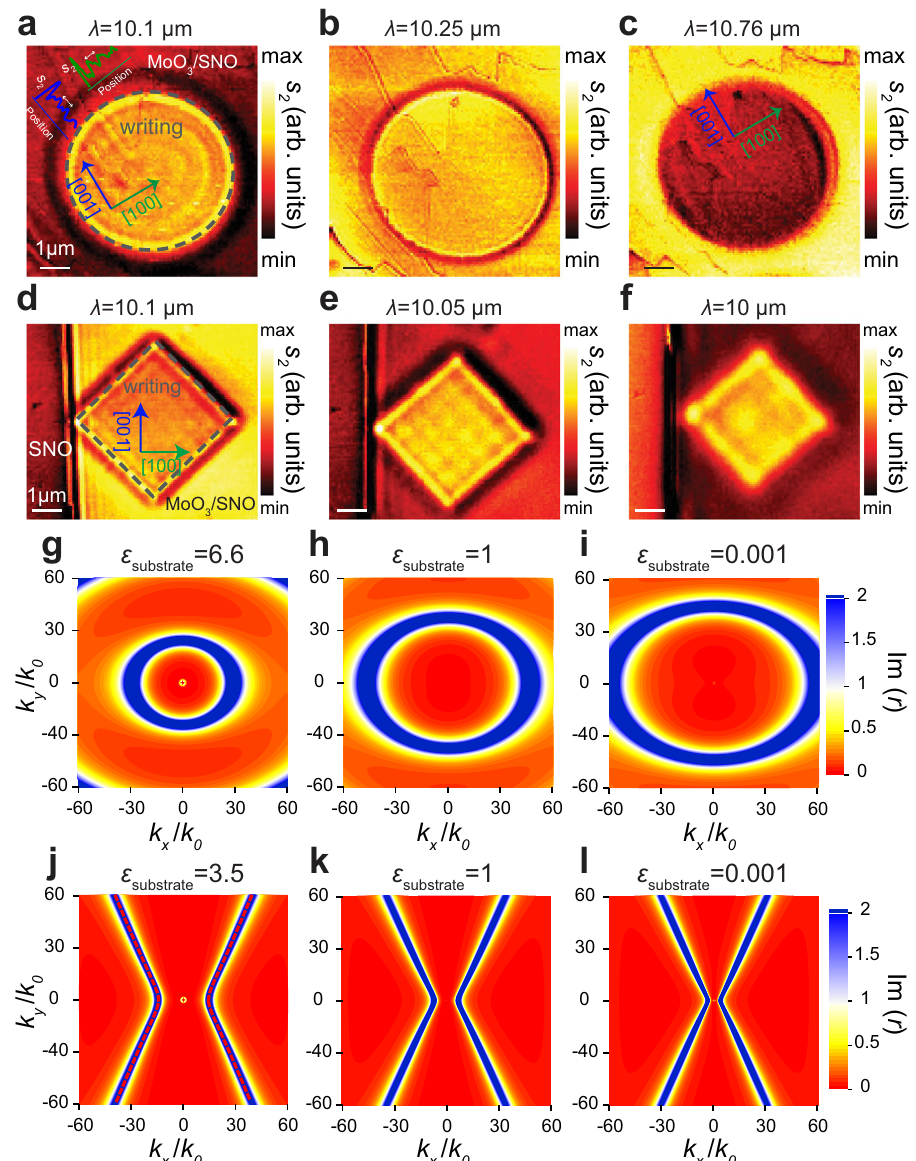
Fig.5|Tunablepolaritonicswith α -MoO 3 /SNOarchitectures. IRs-SNOMsecond transferred on the top at part ( a – c ). Gray dashed lines in panels a and d show the charge written region on SNO. g – i Simulated dispersion of polaritons for 100nm harmonic near fi eld experimental amplitude s 2 images of pristine α -MoO 3 /SNO at a λ =10.1 µ m, b λ =10.25 µ m, and c λ =10.76 µ m. The lithography pattern (a circle thick α -MoO 3 on top of the correlated oxide metasurface with different permit- tivity, at the frequency of 990.09cm − 1 . j – l Dispersion of hyperbolic polaritons for with 5 µ m diameter) was made by applying 10V potential at the c-AFM tip and a fl ake of 120nm α -MoO – c ). IR s-SNOM second 100nm thick α -MoO 3 on top of correlated oxide metasurfaces with different per- 3 is transferred on the top at parts ( a harmonic near- fi eld amplitude s 2 images of pristine α -MoO 3 /SNO at d λ =10.1 µ m, mittivity, at the frequency of 900.9cm − 1 . The graphs in the insets in panel e λ =10.05 µ m, f λ = 10 µ m, the lithography pattern (a square with 4 µ m side) was a represent the line pro fi les along the [100] and [100] directions and illustrated in made by applying 10V potential at the c-AFM tip and a fl ake of 120nm α -MoO 3 is detail in Supplementary Fig. 11. All scale bars in a – f indicate 1 µ